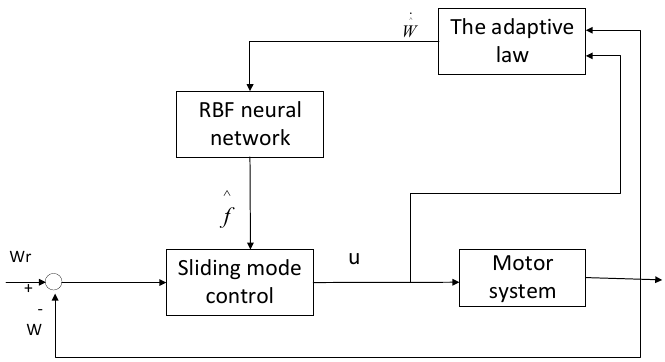
Figure 1. Motor control system based on the RBF neural network.